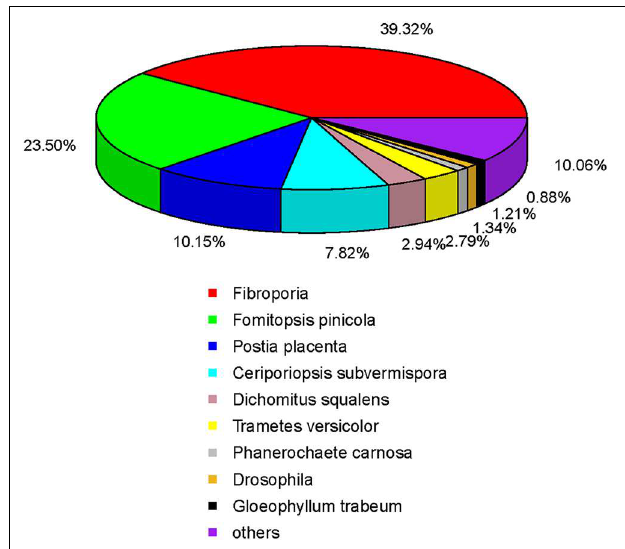
FIGURE 4 | Distribution of the homology search of expressed sequence tags against the nr database.